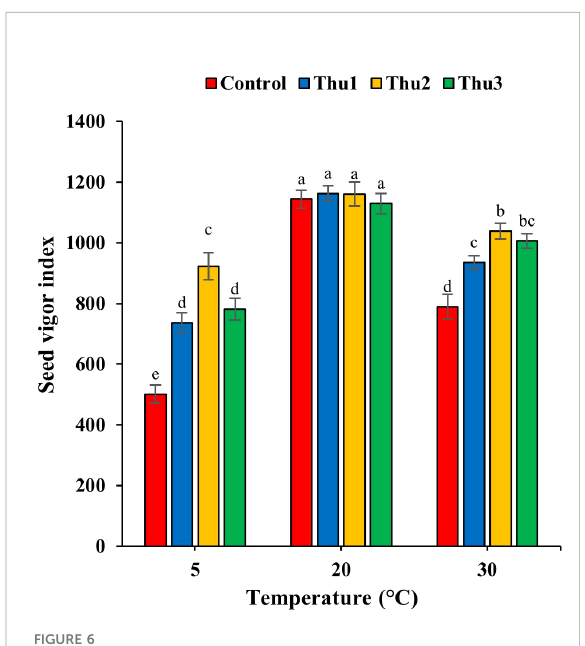
FIGURE 6 Effects of temperature and Th17 concentrations on seed vigor index. Thu1: 10 -7 M Th17, Thu2: 10 -9 M Th17, Thu3: 10 -11 M Th17. Each bar represents mean ± standard error (n=8). Means with the same letters are not signi fi cantly different ( p < 0.05).